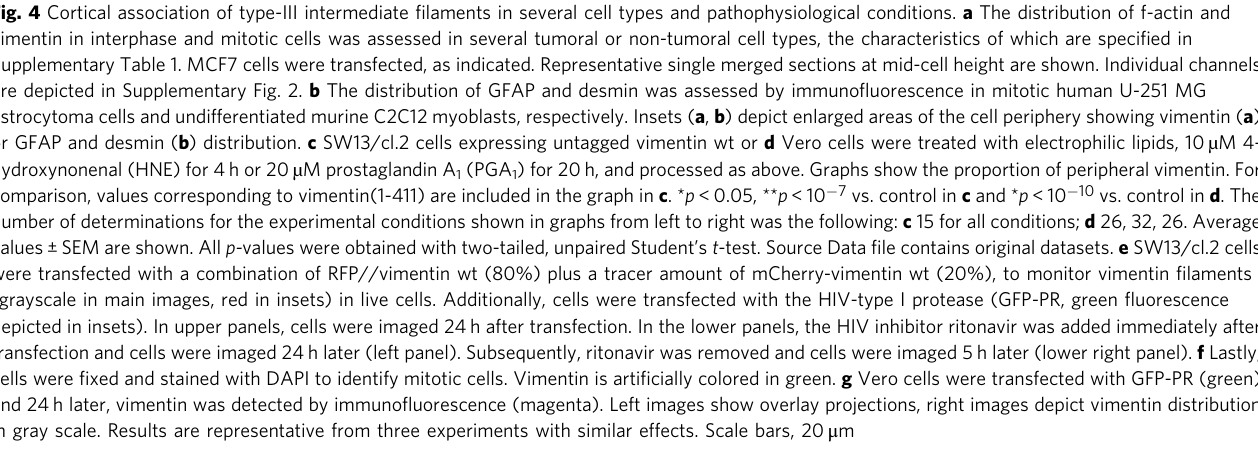
Fig. 4 Cortical association of type-III intermediate fi laments in several cell types and pathophysiological conditions. a The distribution of f-actin and vimentin in interphase and mitotic cells was assessed in several tumoral or non-tumoral cell types, the characteristics of which are speci fi ed in Supplementary Table 1. MCF7 cells were transfected, as indicated. Representative single merged sections at mid-cell height are shown. Individual channels are depicted in Supplementary Fig. 2. b The distribution of GFAP and desmin was assessed by immuno fl uorescence in mitotic human U-251 MG astrocytoma cells and undifferentiated murine C2C12 myoblasts, respectively. Insets ( a , b ) depict enlarged areas of the cell periphery showing vimentin ( a ) or GFAP and desmin ( b ) distribution. c SW13/cl.2 cells expressing untagged vimentin wt or d Vero cells were treated with electrophilic lipids, 10 µ M 4- hydroxynonenal (HNE) for 4 h or 20 µ M prostaglandin A 1 (PGA 1 ) for 20 h, and processed as above. Graphs show the proportion of peripheral vimentin.